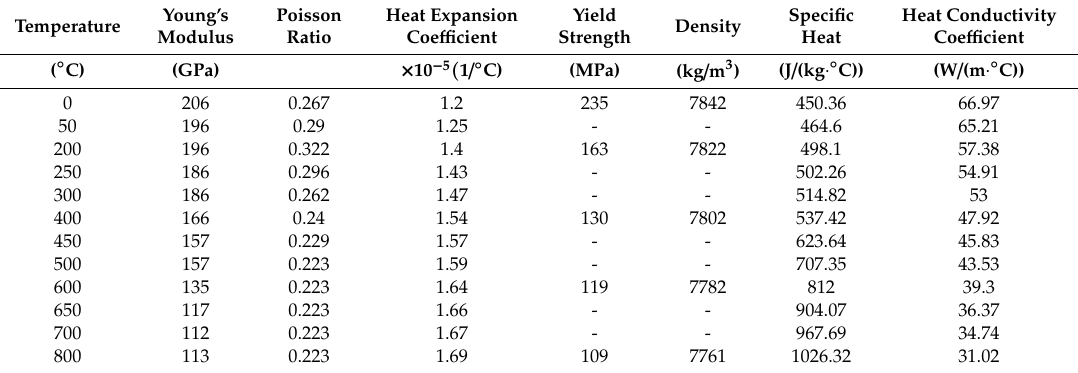
Figure 4. FEM model for the mechanical and heat transfer calculation. Table 1. Material properties of the